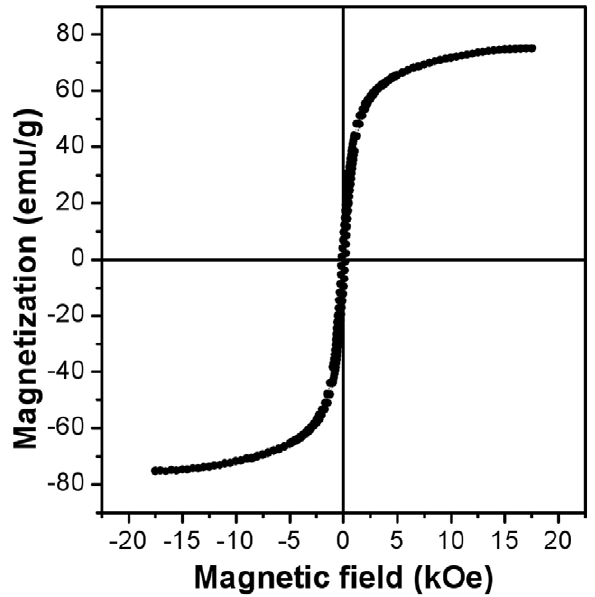
Figure 5. Biocompatibility of Mag@SiO2 nanoparticles assess- ed using MTT assay after their exposure to PC3 cancer cells for 24 h with respect to different Fe concentration in Mag@SiO2